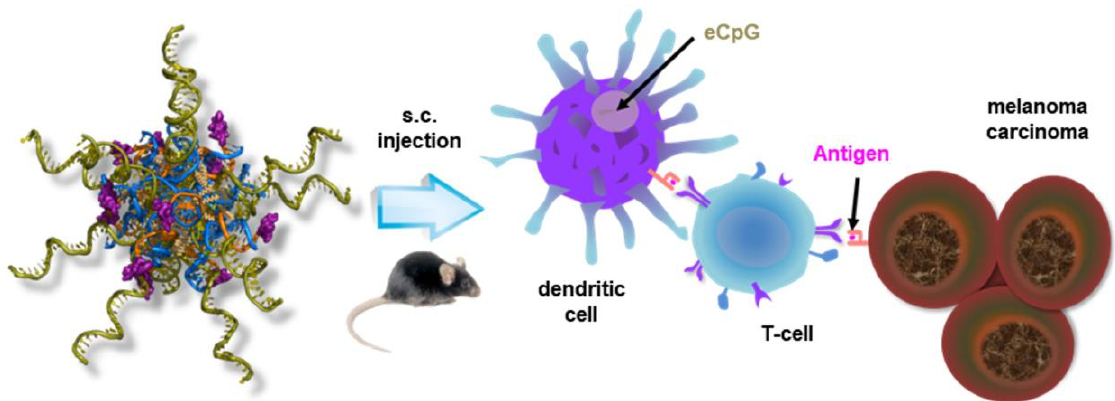
Figure 7. Schematic representation of nucleic acid-based micelle’s immunotherapy. Reproduced from ref. [55].